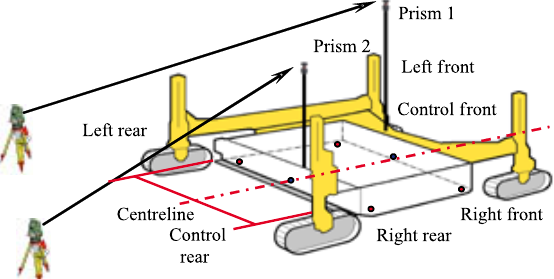
Fig. 11. Control points – mainline concrete paver (Stempfhuber